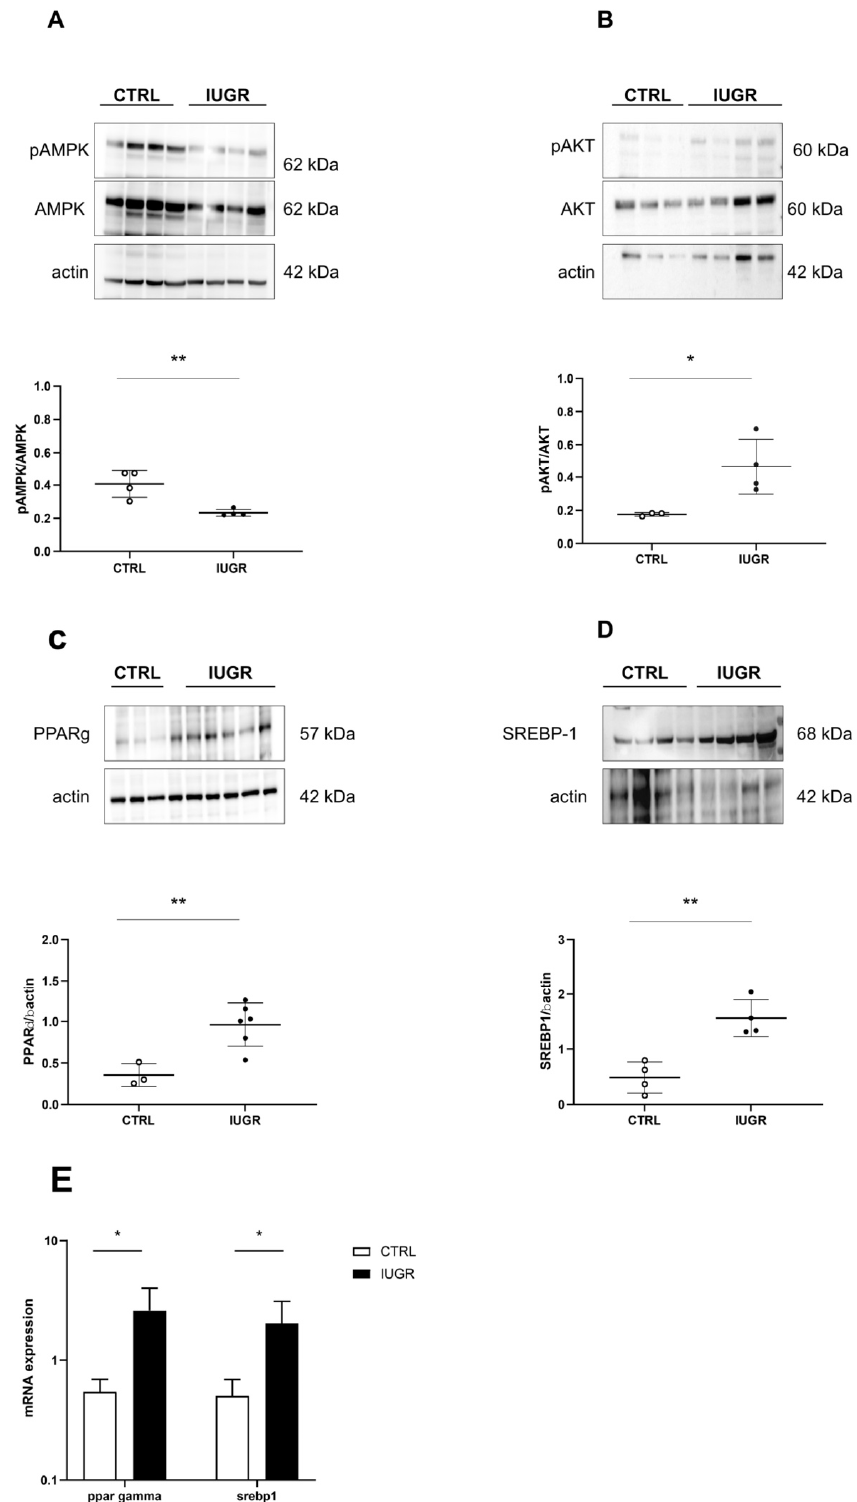
Figure 5. Molecular pathways related to liver lipogenesis in CTRL and IUGR males at 6 months of age. Protein expressions of pAMPK/AMPK ( A ), pAKT/AKT ( B ), PPAR γ ( C ), and SREBP1 ( D ) were measured through Western blot. * p < 0.05; ** p < 0.01; n = 3–5 animals/group. The mRNA expression levels of ppar-gamma ( E ) and srebp1 ( E ) normalized to β -actin were determined using RT–qPCR in CTRL and IUGR male livers. * p < 0.05; n = 5